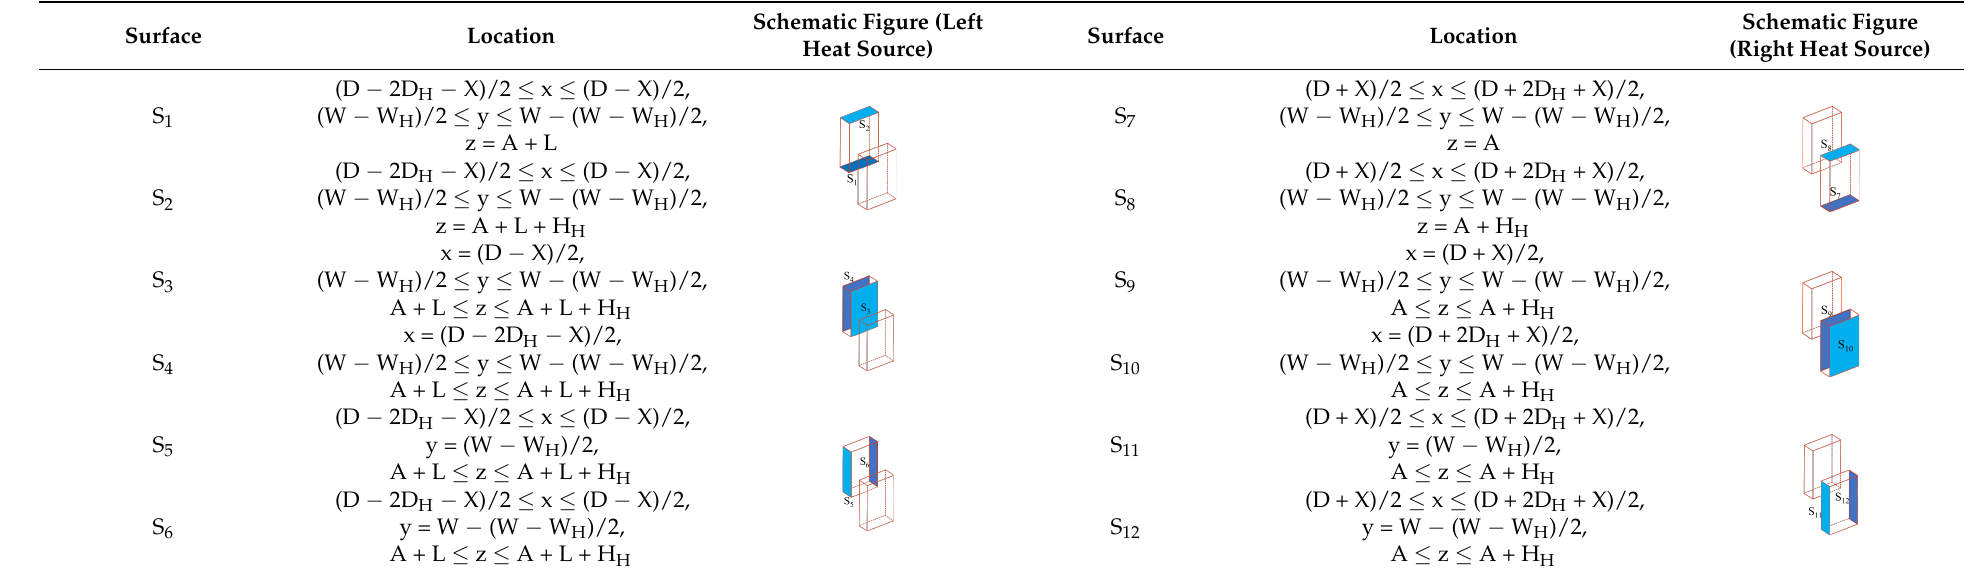
Table 2. Nomenclature of surfaces of two discrete heat sources.